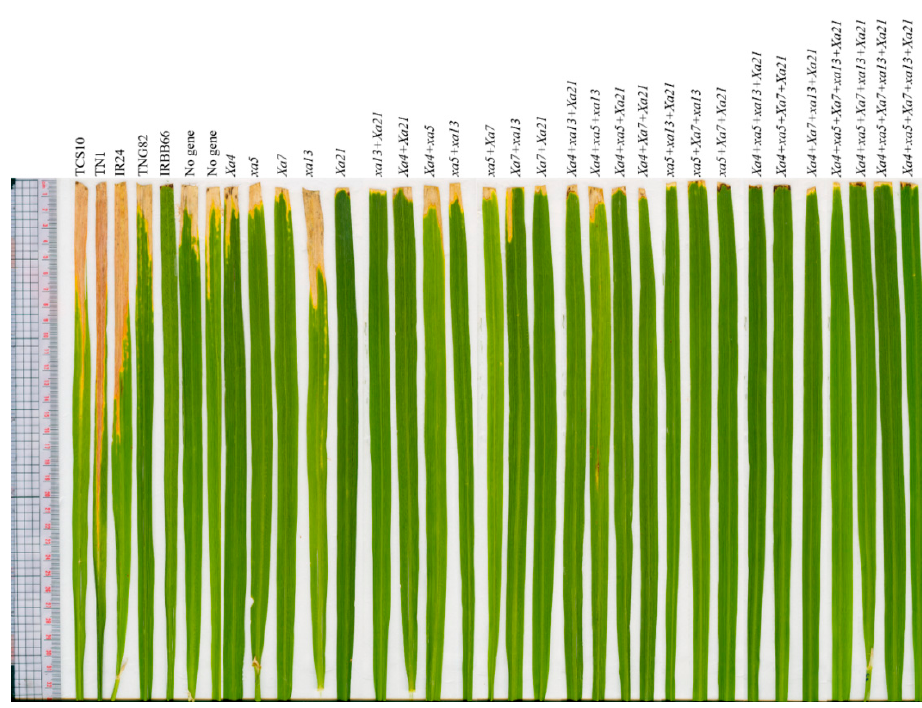
Figure 5. The leaf lesion photo of TNG82/IRBB66 BC 2 F 3 genotypes after 21 days inoculum of bacterial blight pathogen XF89-b in the field at the first crop season in 2016. Susceptible cultivar check: TCS10, IR24, and TN1; Parents: TNG82 and IRBB66.